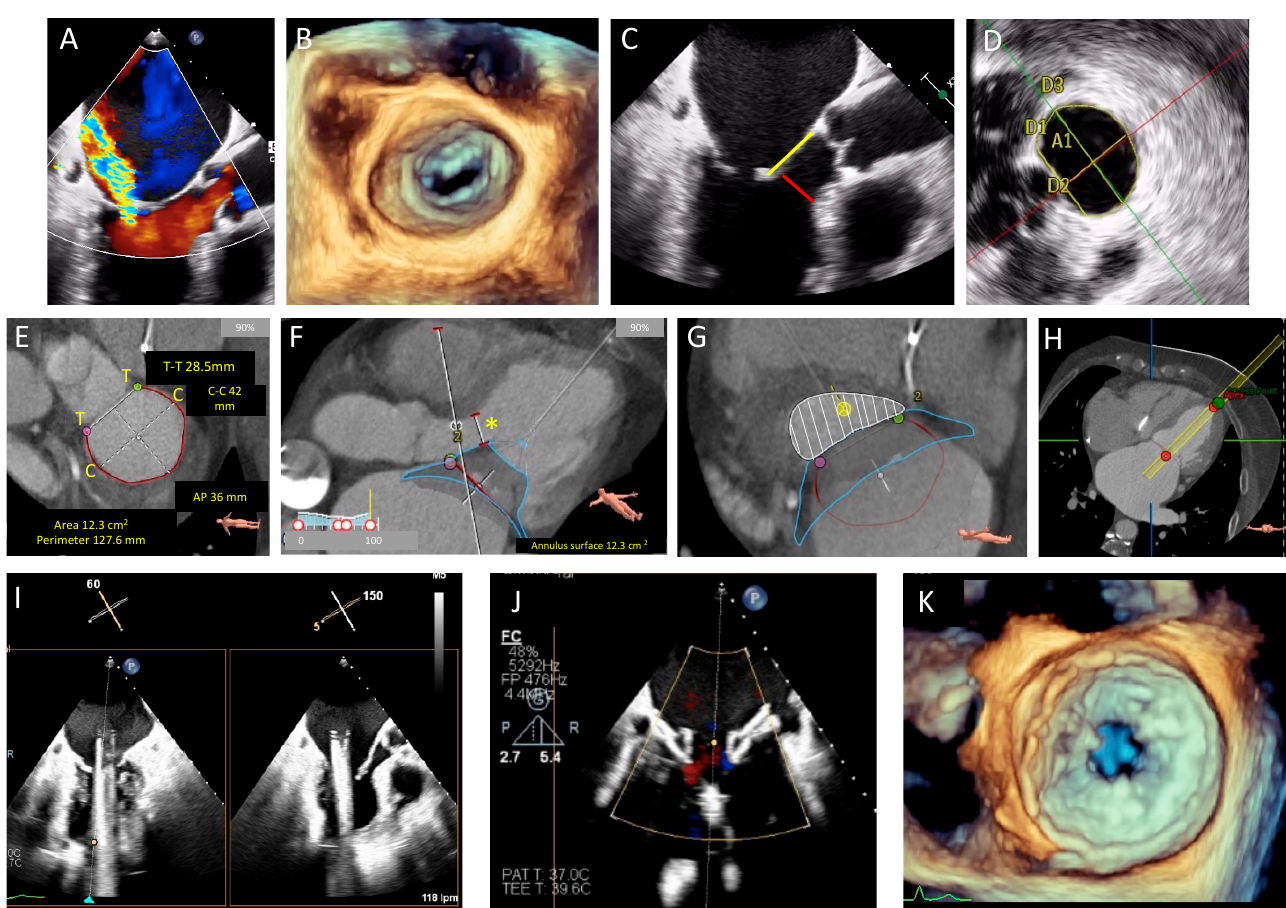
Figure 2. TEE and cardiac computed tomography (CT) planning for a transcatheter Tendyne™ procedure in a patient with severe MR and calcified leaflets. ( A ): Severe MR with a posteriorly directed jet, ( B ): 3D transesophageal echo (TEE) demonstrating calcified leaflet tips unsuitable for edge-to- edge repair. ( C ): Calcified mitral valve (MV) leaflet tips, anterior MV leaflet (AMVL) length 25 mm (yellow) and AMVL to septum distance of 6 mm (red) (measured to assess risk of left ventricular outflow tract obstruction (LVOTO). ( D ): 3D assessment of MV annular area (A1 = 12 cm 2 ), perimeter (13.1 cm), AP dimension (D2 = 3.11 cm), inter-trigonal distance (D1 = 3 cm) and intercommisural distance (D3 = 4.6 cm). ( E ): CT planning demonstrating MV dimensions (T to T = intertrigonal distance, perimeter outlined in red, anteroposterior (AP) distance and intercommisural distance (C to C)). ( F ): Simulated Tendyne™ with predicted neo-LVOT diameter (yellow asterisk). ( G ): Simulated Tendyne with predicted neo-left ventricular outflow tract (neo-LVOT) area of 4.6 cm 2 (white shaded area), ( H ): CT assessed apical puncture site for correct orientation with the MV. ( I ): Intraprocedural TEE guidance with X-plane views showing the delivery system across the MV and in the left atrium (LA), ( J ): Partial liberation of the Tendyne™ system (LP37M) and assessment of paravalvular leak with colour Doppler. ( K ): Liberated Tendyne™ valve with no residual MR, no paravalvular leak, mean transvalvular gradient of 5 mmHg, and no dynamic gradient in the